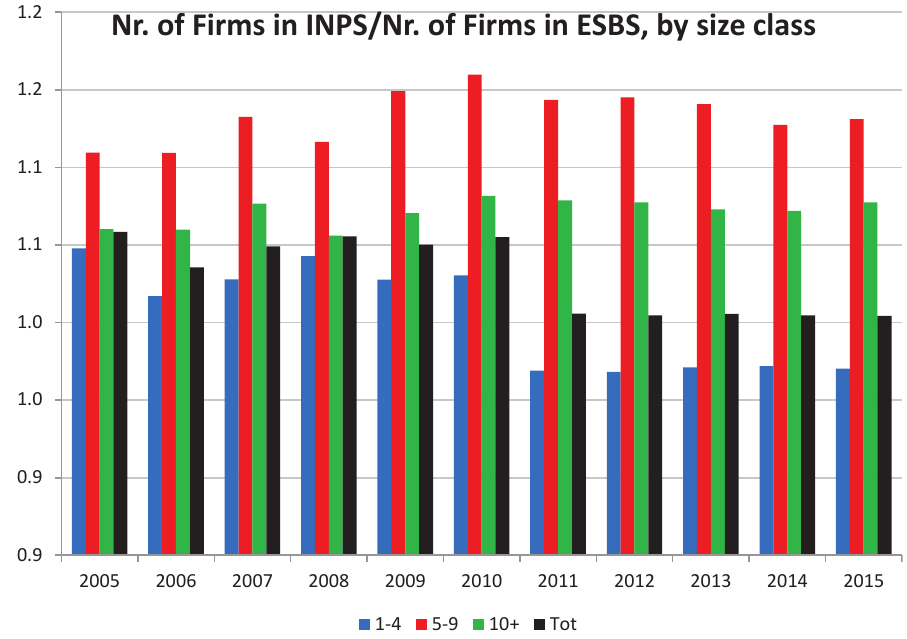
Figure A1 Representativeness of INPS and ESBS databases, class